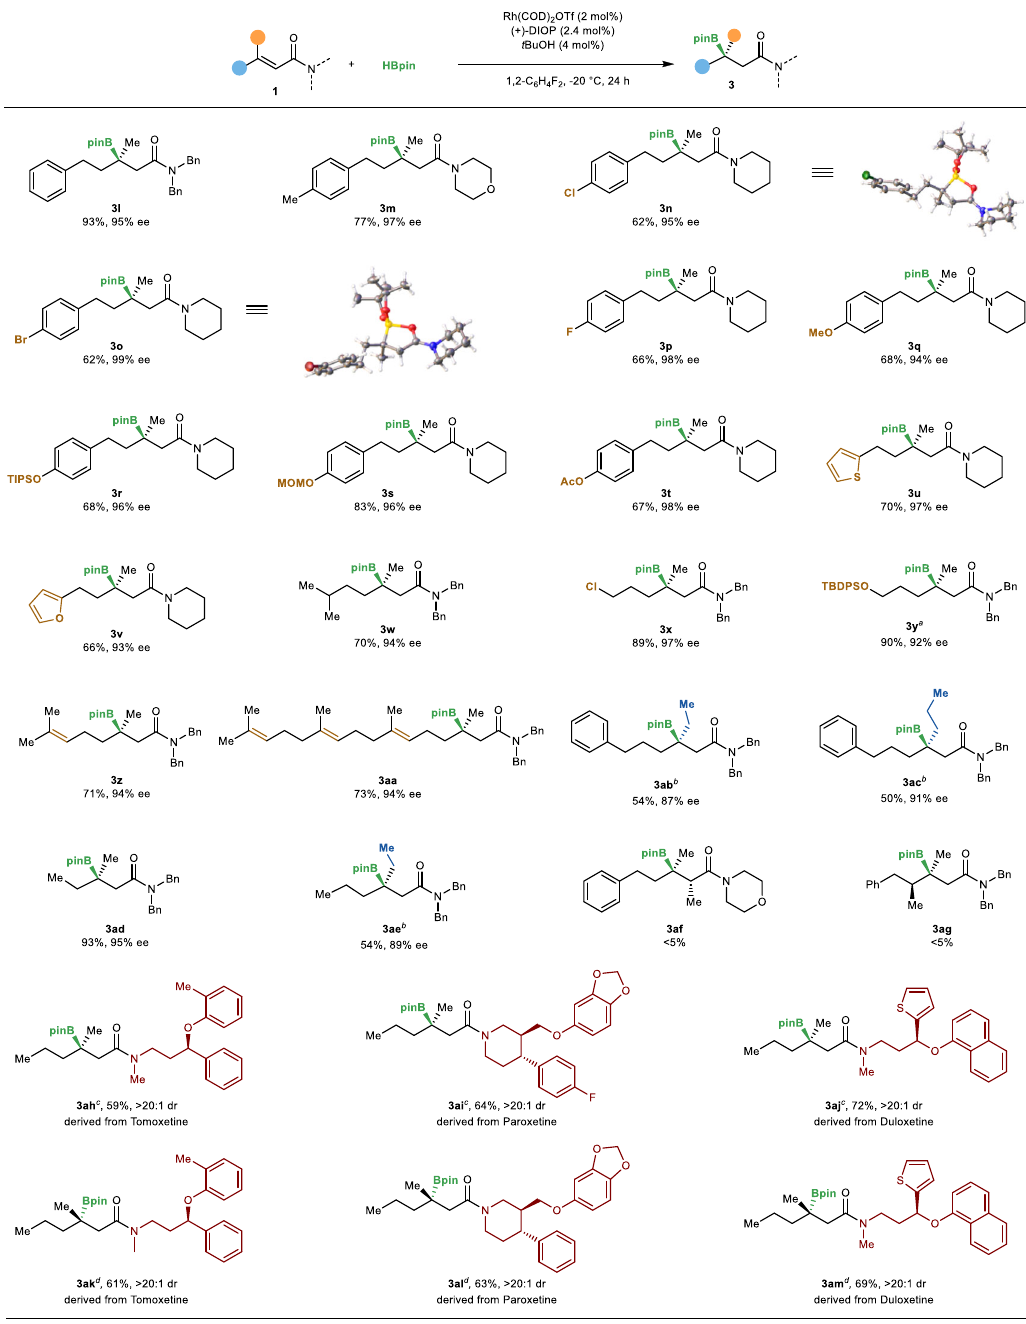
Fig. 3 Substrate scope. Reversed hydroboration of β , β -disubstituted α , β -unsaturated amide. a 5 mol% Rh catalyst. b 7.5 mol% Rh catalyst, 3.5 equivalent of HBpin, 0 °C. The product was isolated after oxidation. c 5 mol% Rh catalyst. The product was isolated after oxidation. d 5 mol% Rh catalyst, 6.0 mol% ( − )-DIOP. The product was isolated after oxidation. TIPS triisopropylsilyl, MOM methoxymethyl, TBDPS t